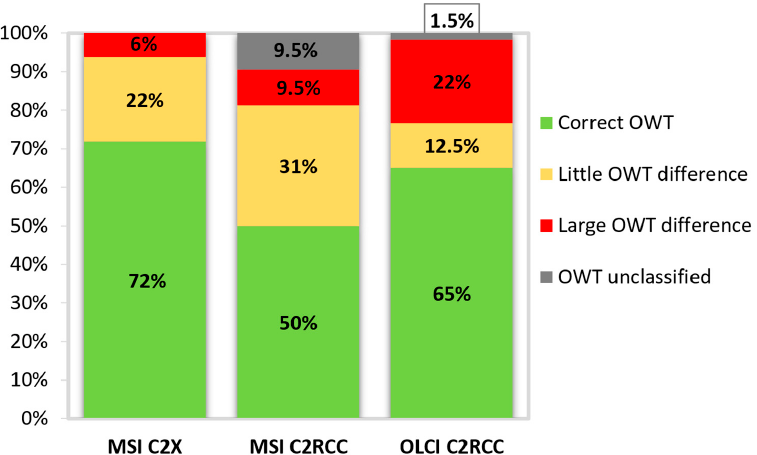
Figure 5. The distribution of the derived optical water types (OWTs) accuracy: same OWT as in-situ defined as correct OWT (green); neighboring OWT from in-situ defined as little OWT difference (yellow); more than neighboring OWT than in-situ defined as large OWT difference (red); and not classified to any OWT (grey).